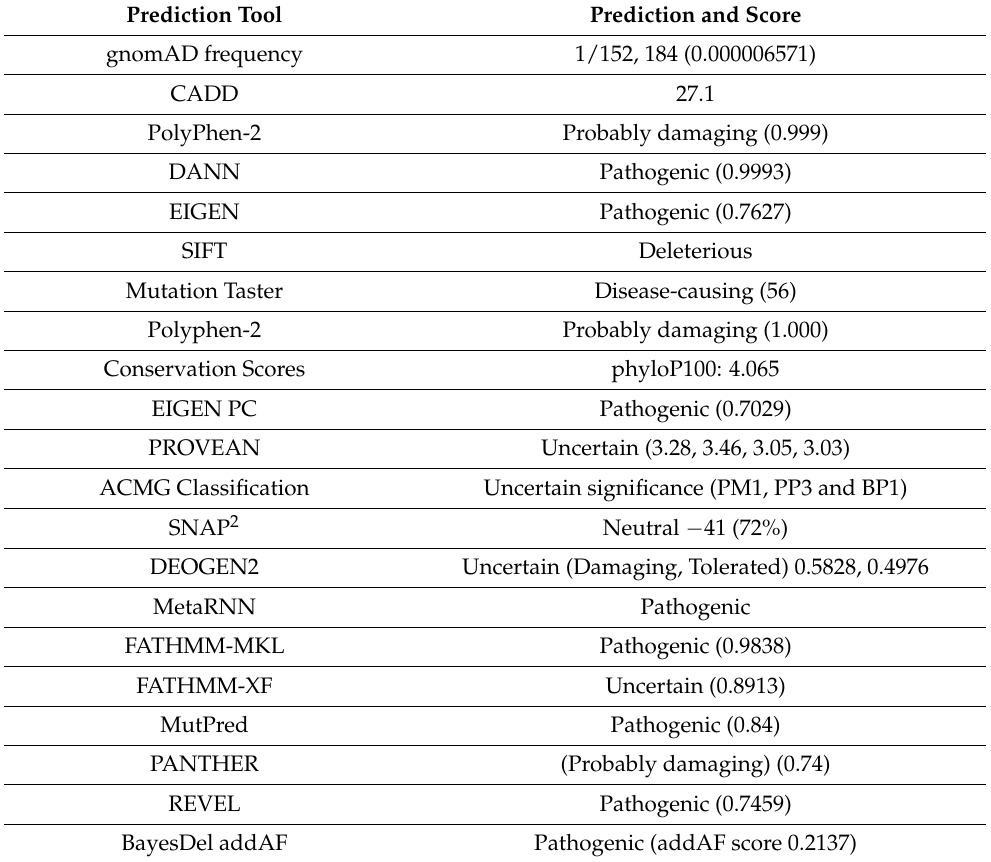
Table 2. In silico analyses for pathogenicity of MBOAT7 , NM_024298.5: c.757G>A,